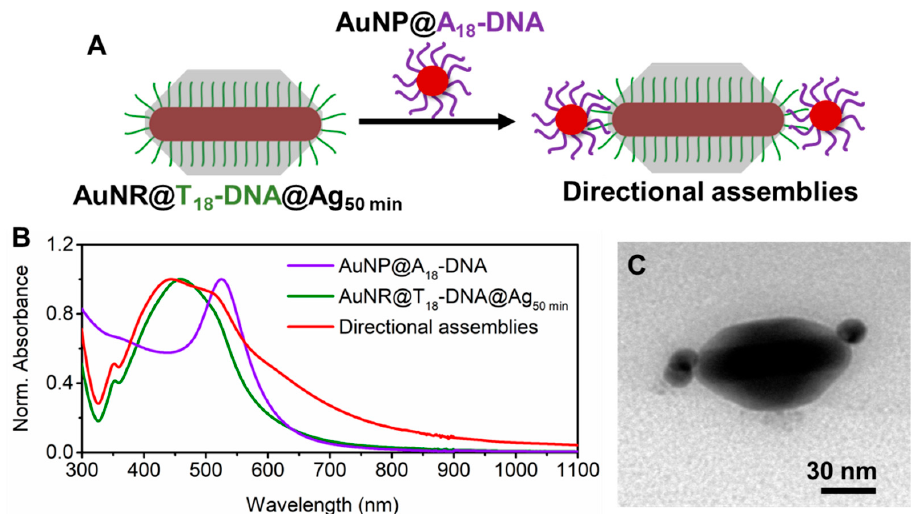
Figure 2. ( A ) Schematic illustration of the formation of anisotropic directional nanoassemblies upon incubation of AuNRs@T 18 -DNA@Ag (overgrown for 50 min) with AuNPs@A 18 -DNA. ( B ) UV–Vis–NIR spectra of each building block and the resulting directional anisotropic nanoassemblies. ( C ) Representative TEM micrograph of the obtained anisotropic directional nanoassemblies.